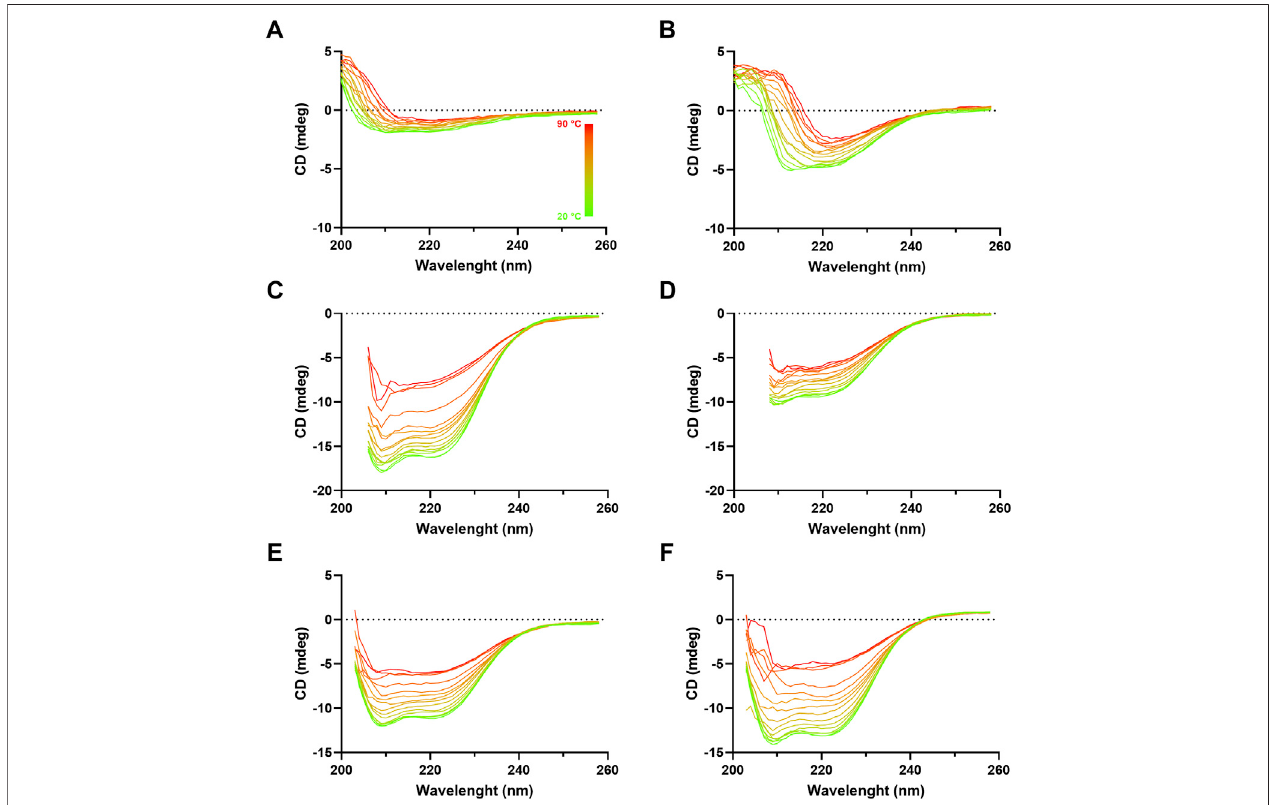
FIGURE 7 | Circular dichroism spectra of in fl uenza VLPs. Far UV (260 – 195 nm) CD spectra analysis of puri fi ed samples (SEC fraction selected) at different temperatures,ranging from20 ° C(green)to90 ° C(red), pH 7.mdeg: milidegrees. (A) H1MonoVLP, (B) H1Penta VLP, (C) H3Mono VLP, (D) H3PentaVLP, (E) BMono VLP, (F) B Penta